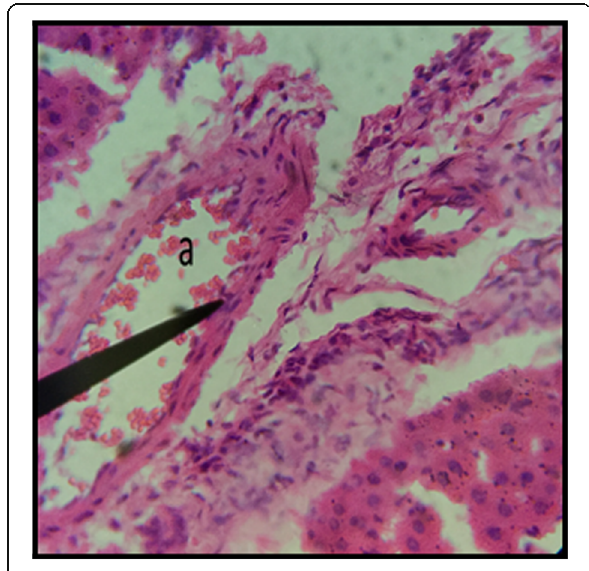
Fig. 18 Liver Section of Female Rat (200 mg/kg/day) X400. a congestion of